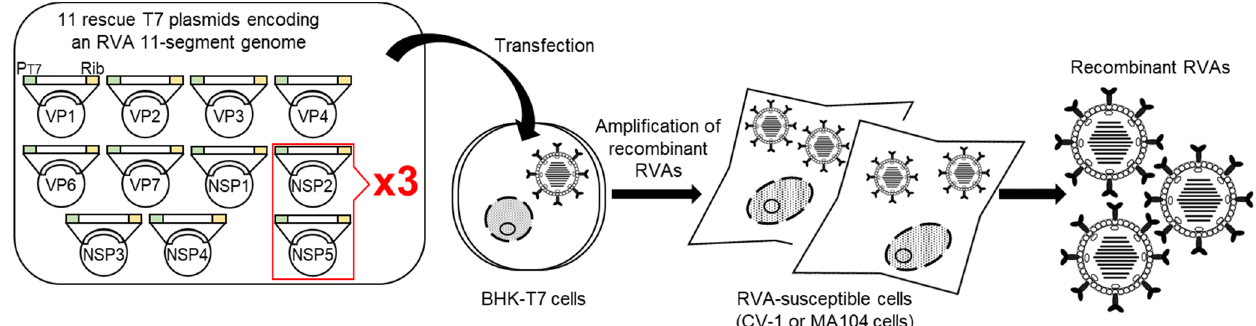
Figure 1. Schematic representation of the 11 plasmid-only reverse genetics system (Komoto’s reverse genetics system). BHK-T7 cells are transfected with a set of 11 rescue T7 plasmids encoding an RVA genome with 3-fold increased propor- tions of T7 plasmids for the NSP2 and NSP5 genes compared to the other nine T7 plasmids. Next day, the transfected BHK-T7 cells are overlaid with RVA-susceptible cells (CV-1 or MA104 cells) and then co-cultured for 3 days for amplifi- cation of recombinant RVAs. Infectious recombinant RVAs can be recovered from the co-cultures. PT7 and Rib denote the T7 RNA polymerase promoter and HDV ribozyme sequence, respectively.